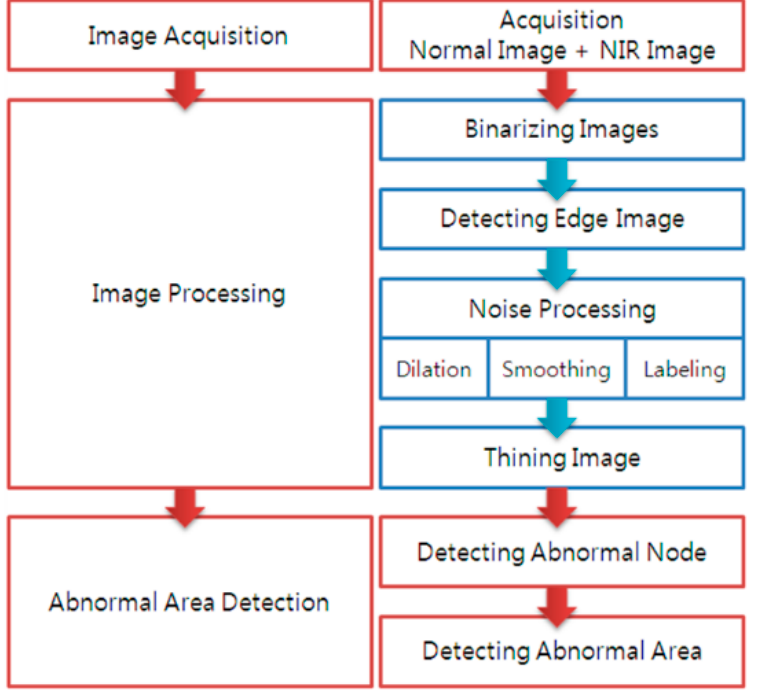
Figure 10. The anomaly-detection image processing algorithm using NIR images.